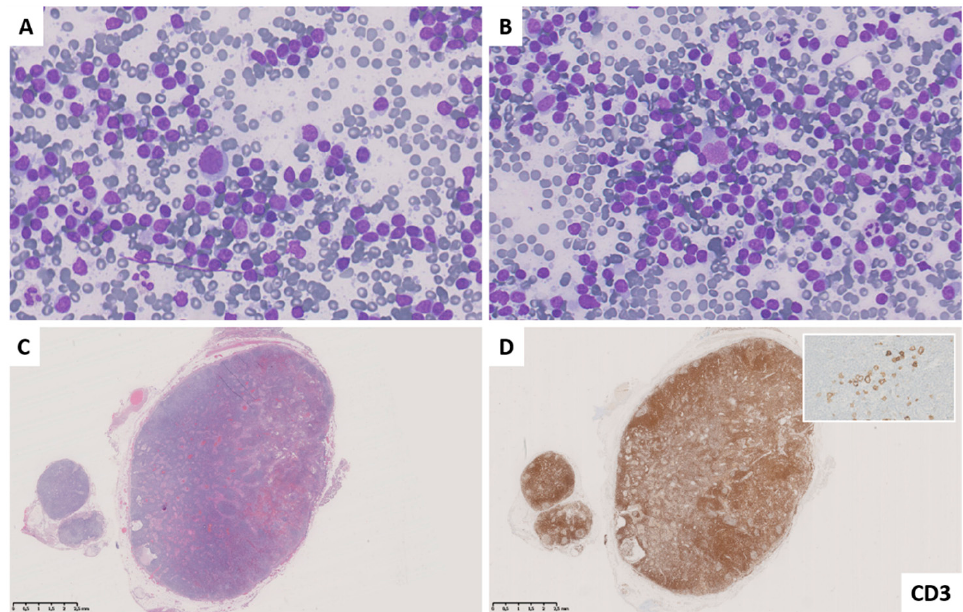
Figure 2. Case L3–4. M, 47 years and history of T-cell rich B-cell lymphoma. Fine needle cytology smear shows a dispersed polymorphous cell population represented by small lymphocytes and few large cells with enlarged and slightly irregular nuclei and scant cytoplasm (( A ) Diff–Quik stain). Histology revealed a benign reactive hyperplasia (( B ) hematoxylin and eosin stain) with interfollic- ular expansion (( C ) CD3) and numerous CD30-reactive immunoblasts ( D ).